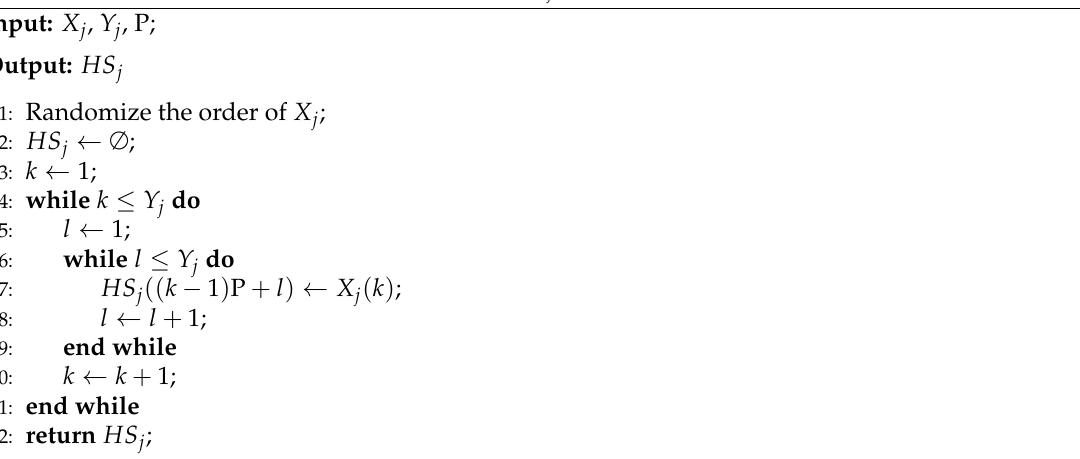
Algorithm 2 Construction of hopping sequence HS j for rendezvous operation of a SU receiver j